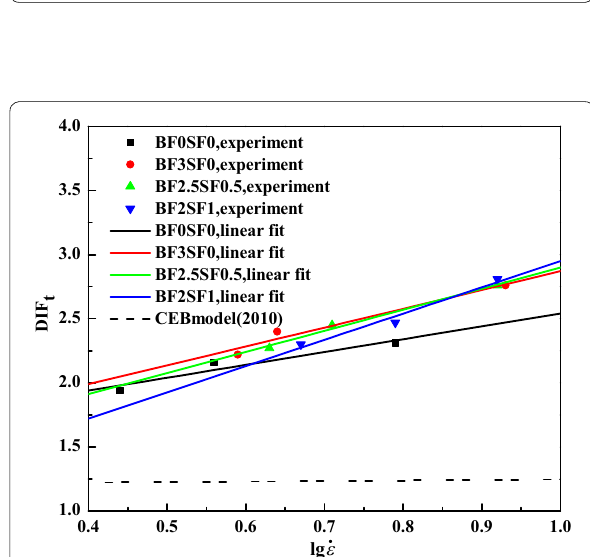
Fig. 11 Dynamic increase factor vs. strain